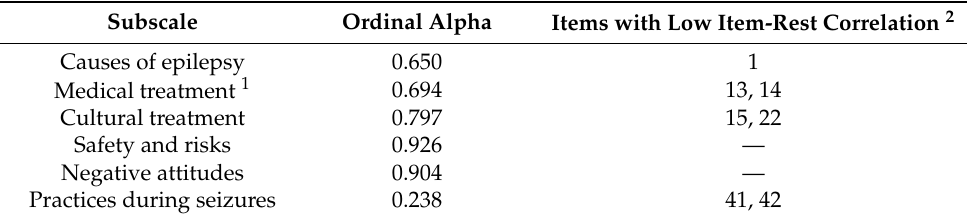
Table 2. Internal consistency in the subscales of the adapted questionnaire of knowledge, attitudes, practices towards epilepsy and items with low item rest